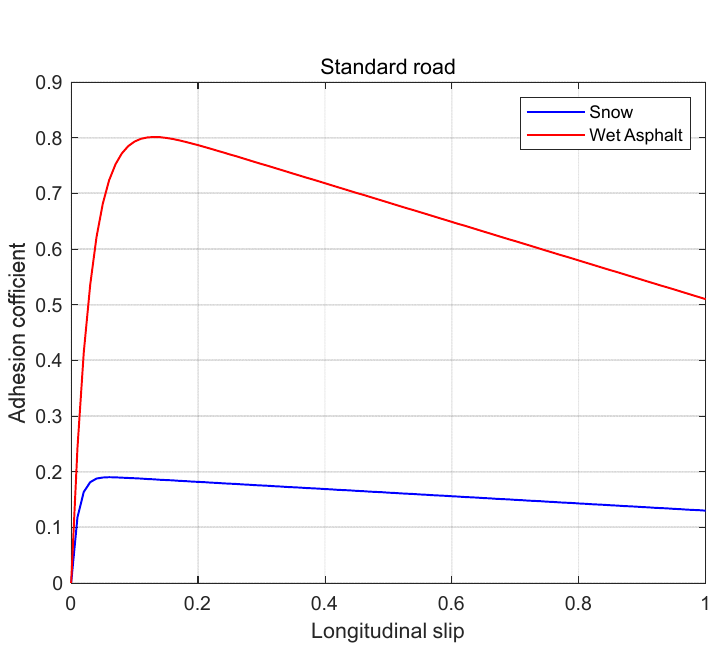
Figure 4. Adhesion coefficient vs. slip.